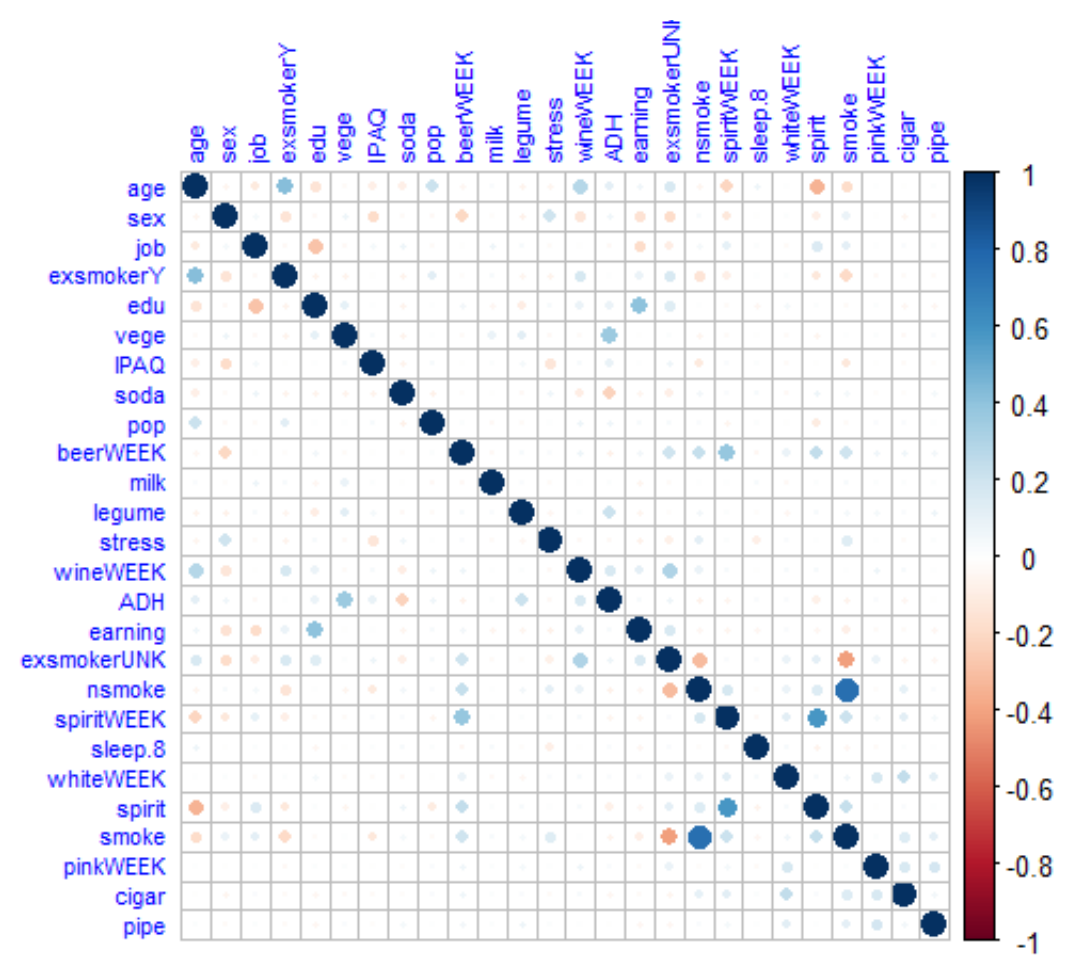
Figure 8. Pearson Correlation Matrix of variables in Figure